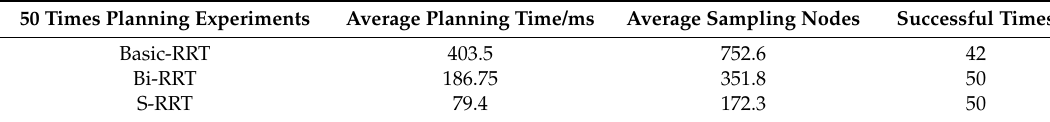
Figure 3. High-dimensional static RRT planning scenario.